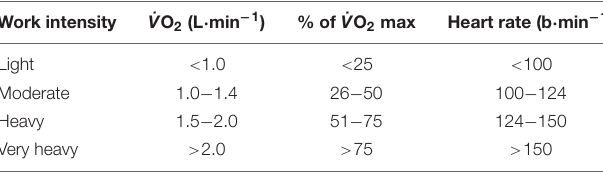
TABLE 2 | Relative work intensity classification based on heart rate in young adult